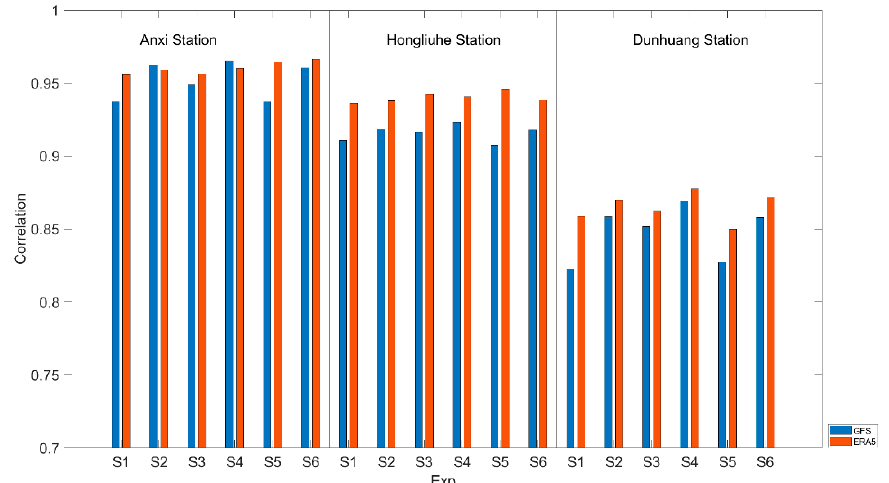
Figure 6. Correlation coefficients between simulated 2-m temperature (T2) and observed T2 with the combinations of different initial data and different parameterization schemes.